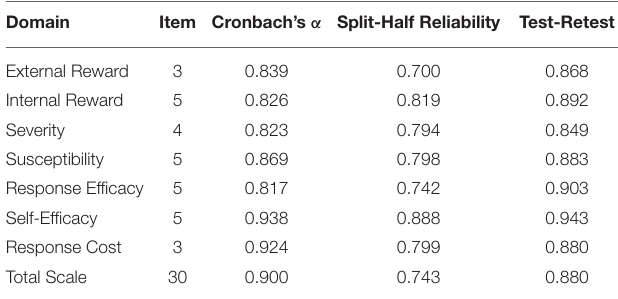
TABLE 9 | Reliability coefficients of the total scale and each domain ( N = 360).